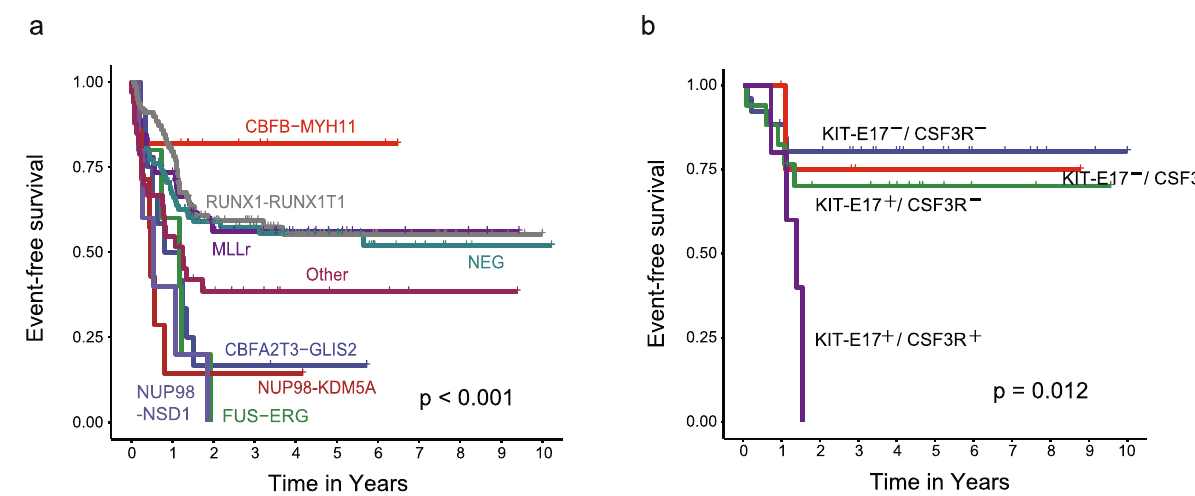
Fig. 4 Event-free survival of Chinese pediatric AML. a Kaplan-Meier estimate of EFS of Chinese pediatric AML patients diagnosed and treated at SCMC. A total of 288 cases with suf fi cient follow-up information were included in this analysis. Patients were grouped by the fusions, including CBFB-MYH11 , 11 cases; RUNX1-RUNX1T1 , 78; KMT2A rearranged (MLLr), 45; CBFA2T3-GLIS2 , 12; NUP98-KMD5A , 7; NUP98-NSD1 , 5; FUS-ERG , 5; other fusions, 33 and fusion negative, 92 (log-rank test, P = 4.963E − 05). b RUNX1-RUNX1T1 -positive patients who reached complete remission after the 1 st cycle of induction therapy, and had both CSF3R and KIT -E17 mutations (5 cases), showed inferior prognosis compared to patients carrying only CSF3R ( n = 5) or KIT -E17 mutation ( n = 17) or none of these two mutations ( n = 26) (log-rank